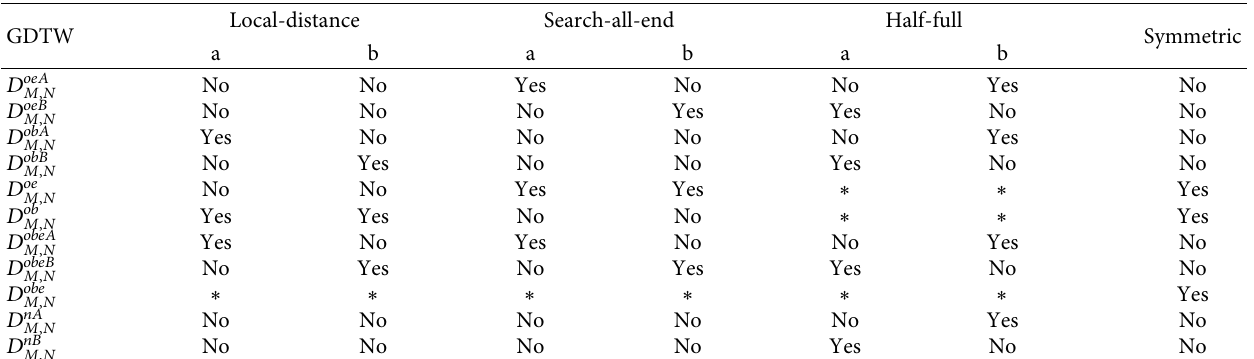
Figure 11: Clustering results of ADPC. Table 3: Generalized